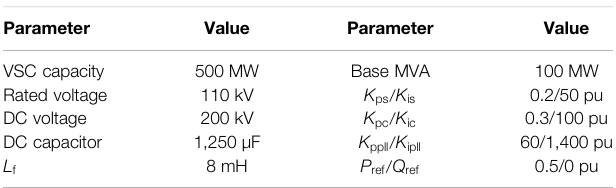
TABLE 1 | Parameters of VSC-HVDC. TABLE 2 | Parameters of the DFIG.